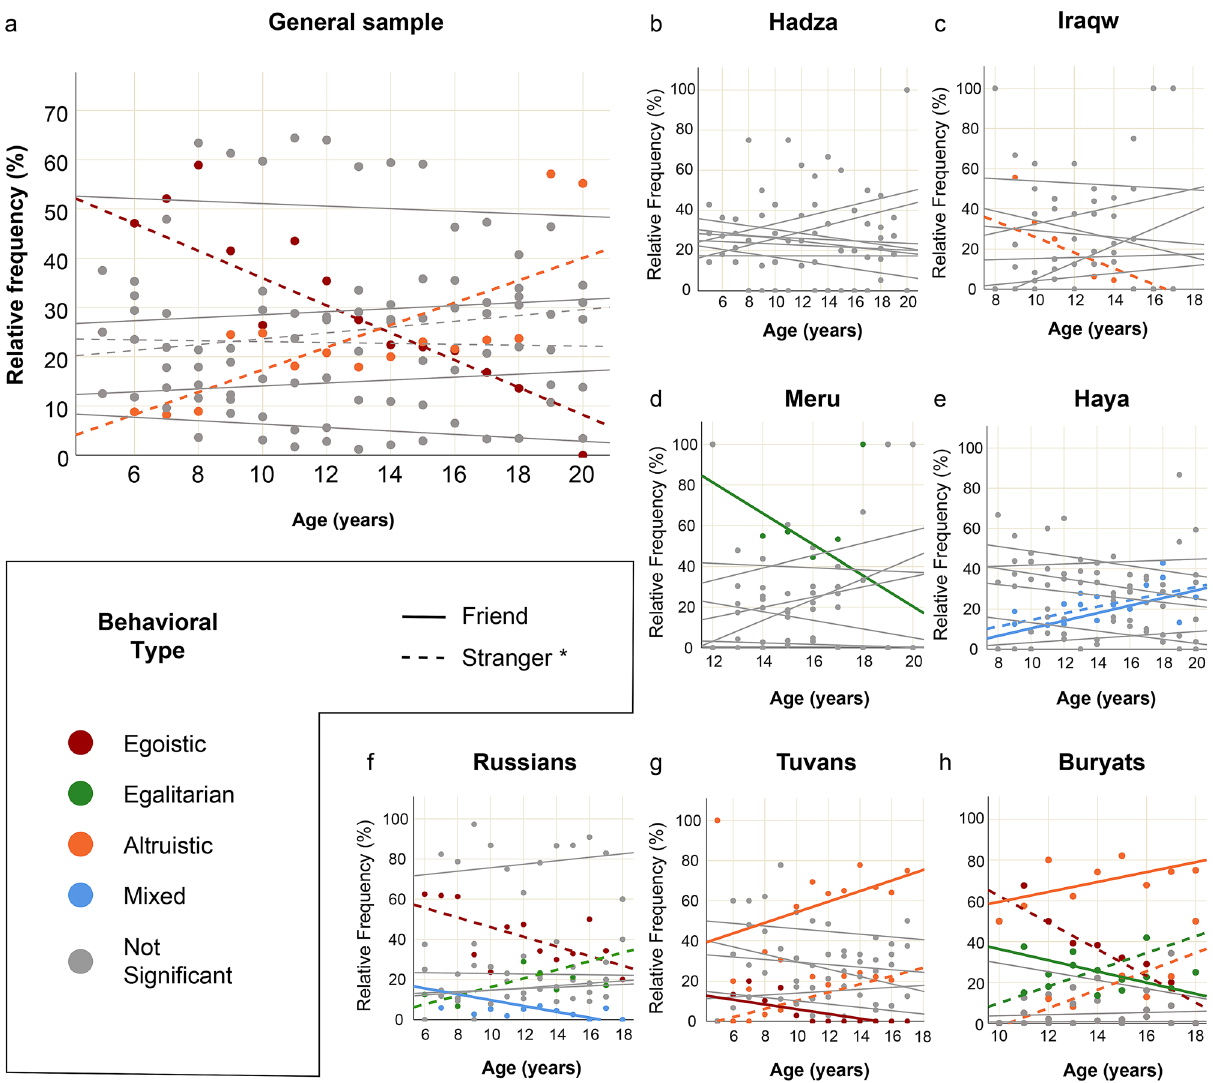
Figure 3. The effect of age on behavior in the games. Linear regression analysis: statistically significant associations (and strong trends) between frequencies of behavioral types and age are presented in color. * To facilitate visual perception, dashed lines for interactions with strangers are presented only for general sample and for significant associations within each ethnic group. ( a ) General sample. Egoistic [stranger]: B = − 2.773, R 2 = 0.670, p < 0.001; Altruistic [stranger]: B = 2.269, R 2 = 0.583, p = 0.001; associations for other behavioral types are not significant. ( b ) Hadza. No significant associations. ( c ) Iraqw. Altruistic [stranger]: B = − 3.930, R 2 = 0.348, p = 0.073; associations for other behavioral types are not significant. ( d ) Meru. Egalitarian [friend]: B = − 7.615, R 2 = 0.344, p = 0.097; associations for other behavioral types are not significant. ( e ) Haya. Mixed